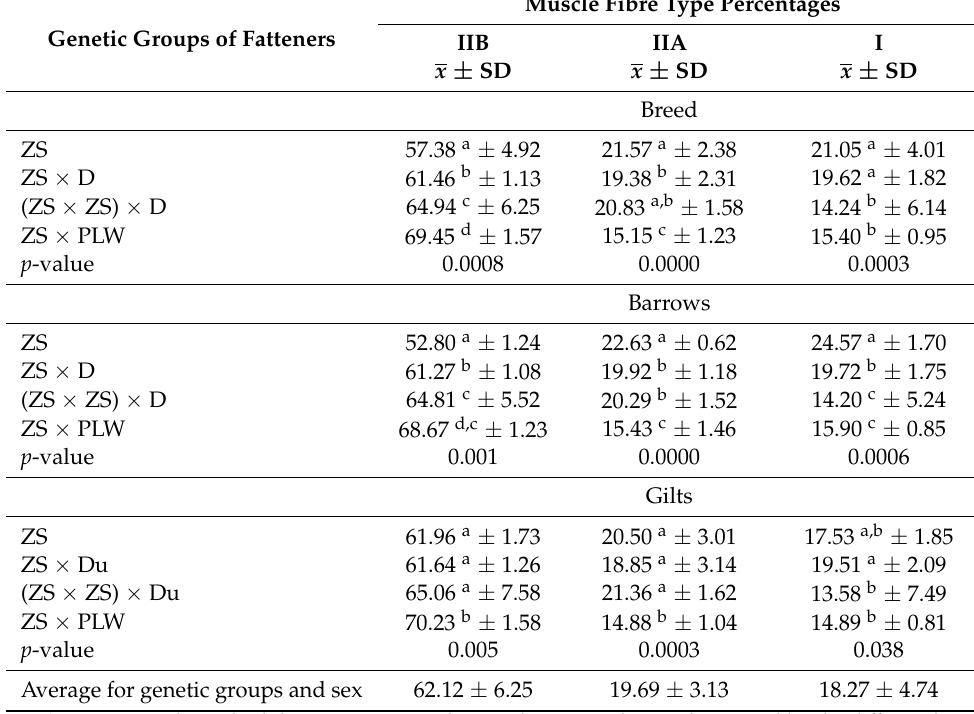
Table 2. The muscle fibre type percentage (%) of the m.longissimus thoracis for male and female fatteners of the Złotnicka Spotted (ZS) breed and the hybrid crosses.